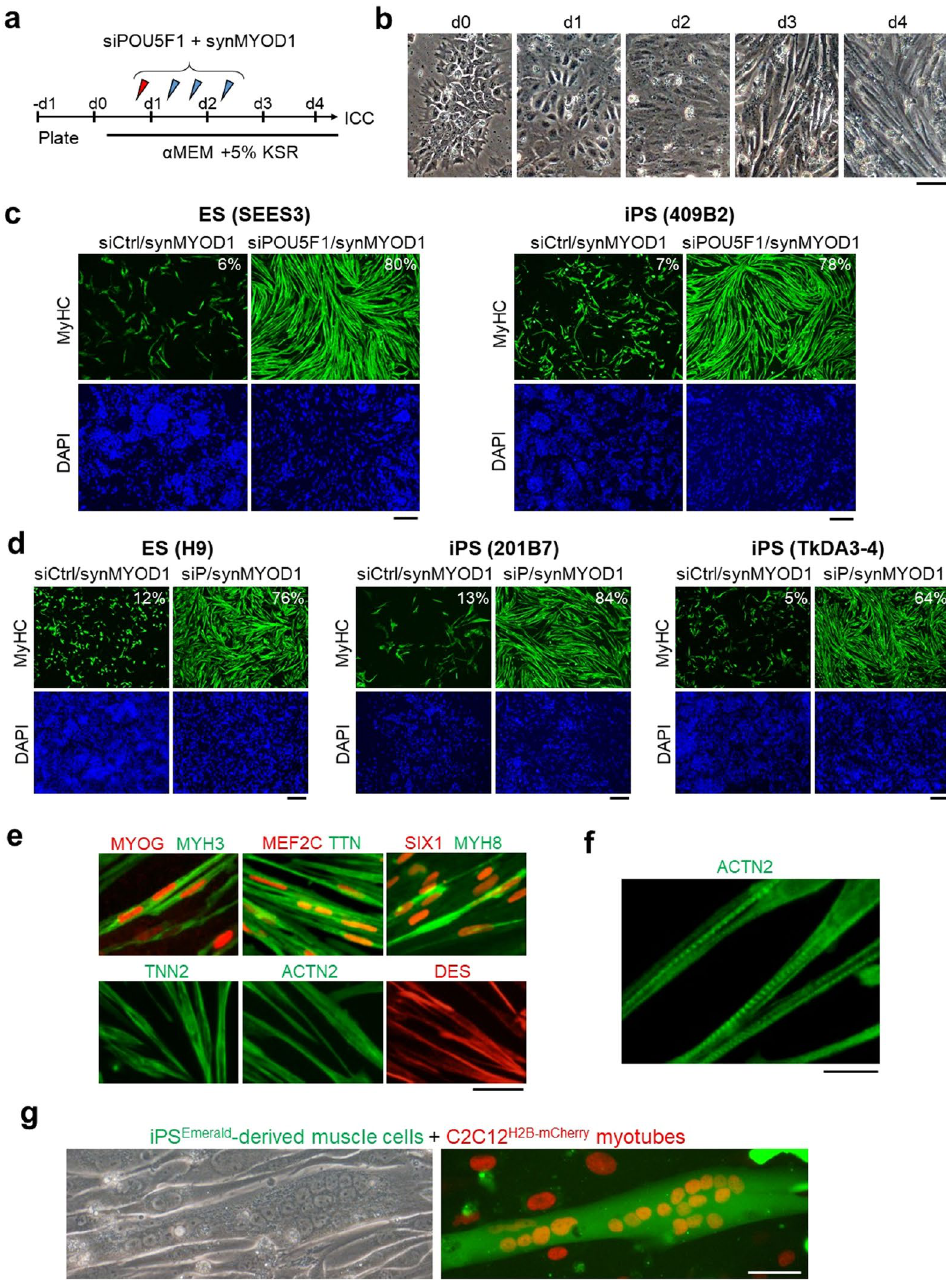
Figure 3. siPOU5F1/synMYOD1 treatment induces efficient myogenic conversion of hPSCs. ( a ) Schematic of the myogenic differentiation protocol. hPSCs were transfected with siPOU5F1 together with synMYOD1 at the indicated time points. The mixture of siPOU5F1/synMYOD1 was transfected on day 0. synMYOD1 was transfected on days 1 and 2. The cells were cultured in α MEM + 5% KSR. ( b ) Morphological changes in the transfected cells. Scale bar, 50 μ m. ( c ) Immunostaining analysis for MyHC in the hPSCs (SEES3 ESCs and 409B2 iPSCs) after the treatment with siControl/synMYOD1 or siPOU5F1/synMYOD1. Nuclei were stained with DAPI. The representative images are shown. The average percentages of MyHC-stained cells are obtained from three independent biological replicates. Scale bar: 200 μ m. ( d ) Immunostaining analysis for MyHC in the hPSCs (H9 ESCs, 201B7 iPSCs, and TkDA3-4 iPSCs) after treatment with siControl/synMYOD1 or siPOU5F1/synMYOD1. Nuclei were stained with DAPI. The representative images are shown. The average percentages of MyHC-stained cells are obtained from three independent biological replicates. Scale bar: 200 μ m. ( e ) Immunostaining analysis for MYOG, MEF2C, SIX1, MYH3, MYH8, titin (TTN), troponin T (TNN2), actinin alpha 2 (ACTN2), and desmin (DES) in the siPOU5F1/synMYOD1-treated cells. Scale bar: 50 μ m. ( f ) Higher magnification of ACTN2 staining. Scale bar: 20 μ m. ( g ) 409B2-iPSCs expressing Emerald GFP were differentiated into myogenic cells and co-cultured with mouse C2C12 myotubes, nuclei of which were labeled with red fluorescence. Next day after co- culturing, cell fusions were detected. Scale bar: 50 μ